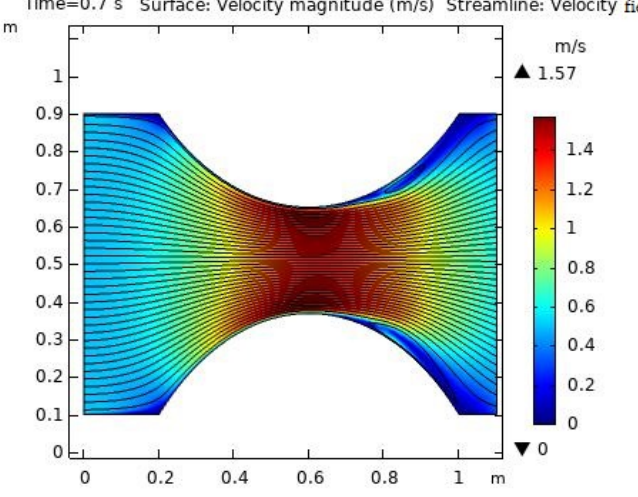
Figure 21. The streamlines at t = 0.7 s.